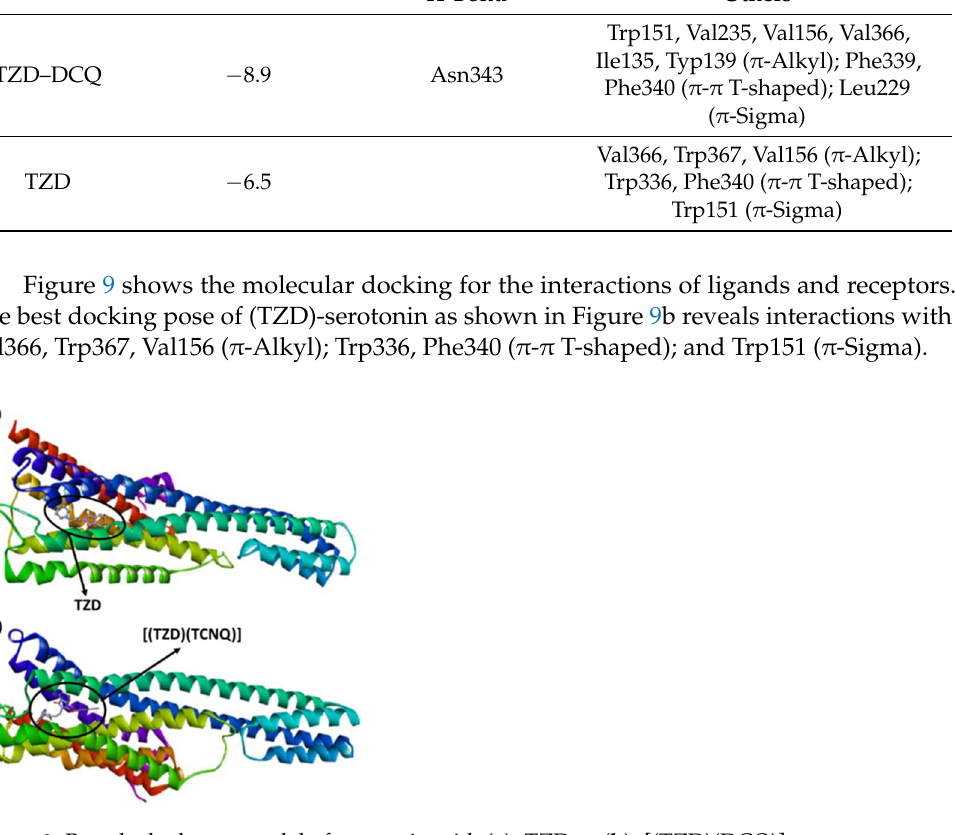
Figure 9. Best docked pose model of serotonin with ( a ): TZD or ( b ): [(TZD)(DCQ)]. 3D representations of TZD-serotonin or [(TZD)(DCQ)-serotonin are shown in Figure